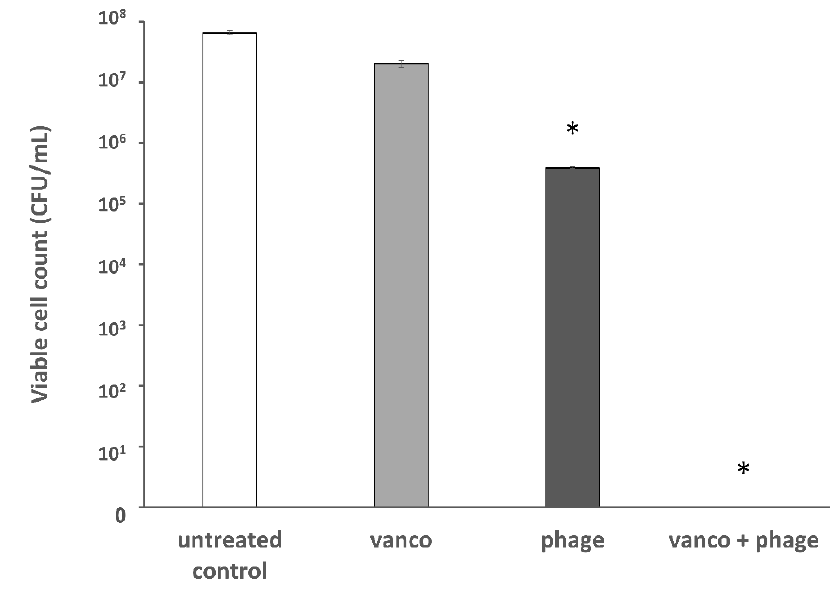
Figure 3. Viable counts of planktonic vancomycin-resistant E. faecalis following a combined treatment of phage EFLK1 and vancomycin. The colony forming units (CFU) / mL of VRE treated with 0.015 mg / mL vancomycin combined with phage EFLK1 1.2 × 10 8 PFU / well is presented. Bacteria were below the limit of detection after treating the cells by combining phage EFLK1 and vancomycin. Bacteria treated only with vancomycin showed survival scores like those of the untreated bacteria; cells treated with phage EFLK1 showed medium survival rates. Combining vancomycin and phage EFLK1 caused seven log reductions in CFU / mL. Light gray = vancomycin-treated bacteria, dark gray = phage EFLK1 treatment, black = phage EFLK1 + vancomycin. Statistically significant ( p < 0.01) compared to the untreated control. The results are mean ± SD based on three independent biological